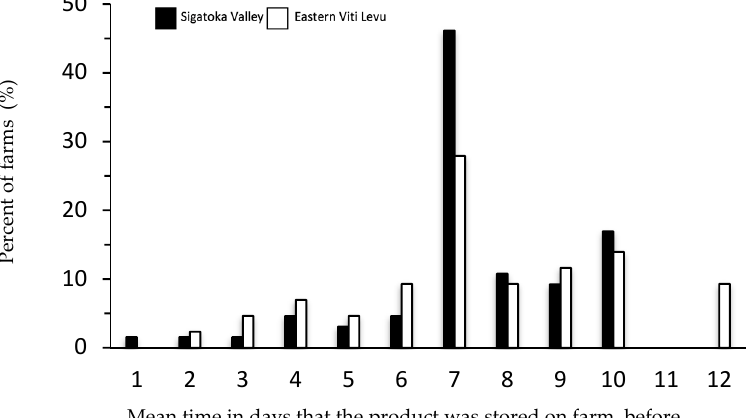
Figure 4. Number of days that product was held on-farm to ripen prior to transport to market, for smallholder tomato farmers in the Sigatoka Valley and Eastern Viti Levu, Fiji.